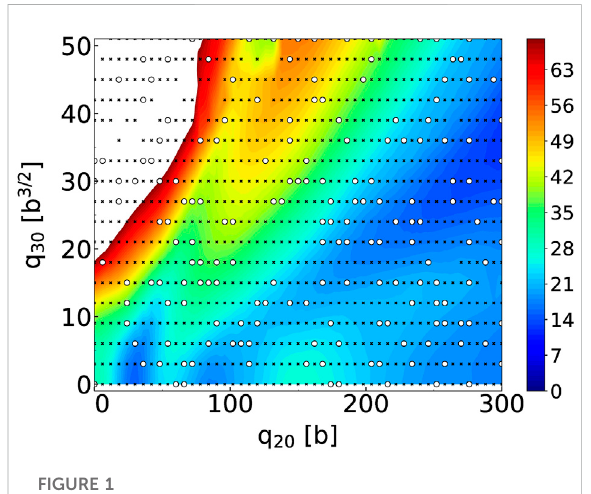
FIGURE 1 Potential energy surface of 240 Pu with the SkM* EDF for the grid ( q 20 , q 30 ) ∈ [0 b, 300 b] × [0 b 3/2 , 51 b 3/2 ] with steps δ q 20 = 6 b and δ q 30 = 3 b 3/2 . The black crosses are the training points, the white circles the validation points. Energies indicated by the color bar are in MeV relatively to − 1820